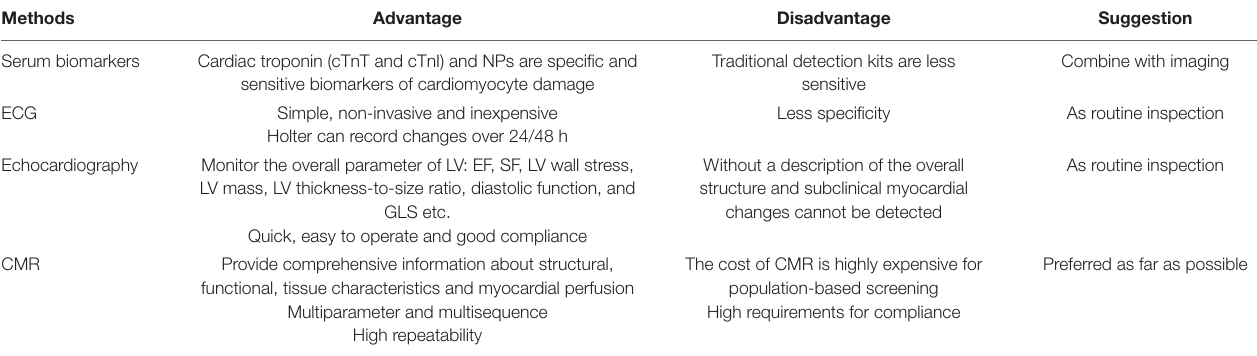
TABLE 1 | Common methods for monitoring cardiotoxicity.